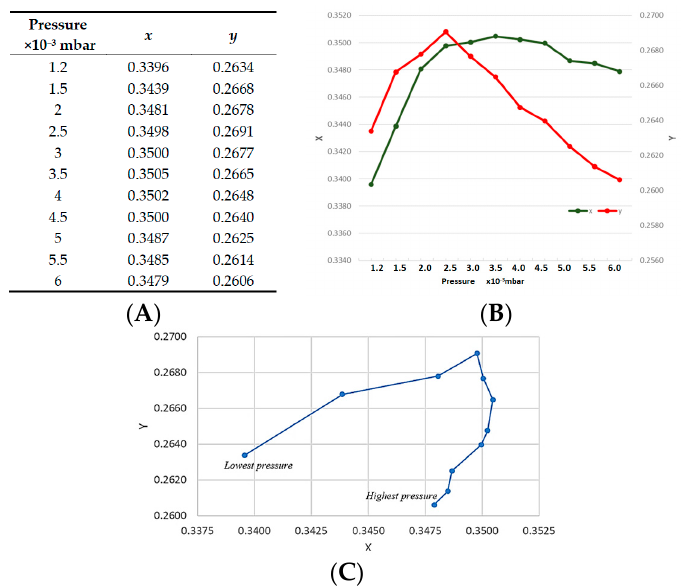
Figure 7. The x and y data obtained by Jeti spectrometer from the plasma at 100 W 2 h after stabilization for a magnetron fitted with IZO target under gas Ar at various pressures ( A ). Newly added, please confirm. As the Argon pressure is increased, the x and y values increase until about 2.5 × 10 − 3 mbar and then start to decrease ( B ). The x and y plot demonstrates a U-turn formation, indicating that the colour is initially shifting toward white and then reverting toward blue ( C ).